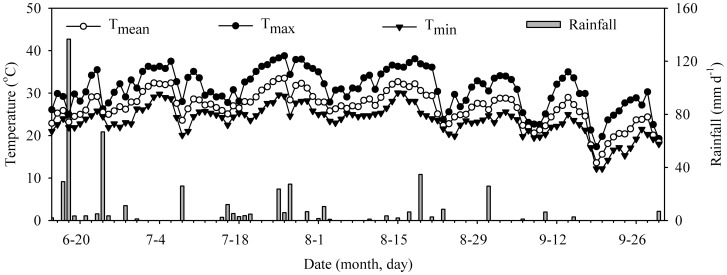
Air temperature records and rainfall events at the study site during the experimental period.(Tmean: mean temperature; Tmax: maximum temperature; Tmin: minimum temperature).